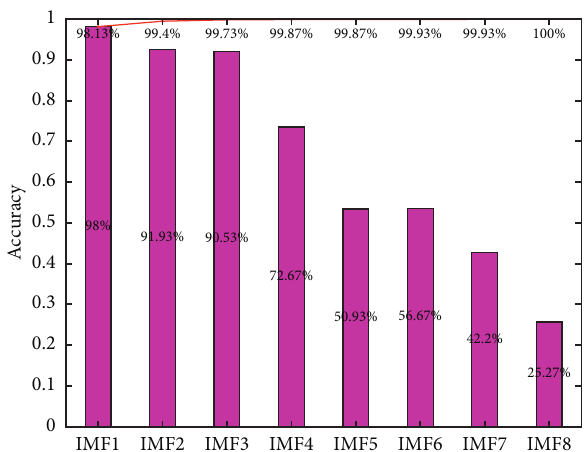
Figure 6: Diagnosis accuracy produced by ensemble DMLYu based on BBM with first n IMF